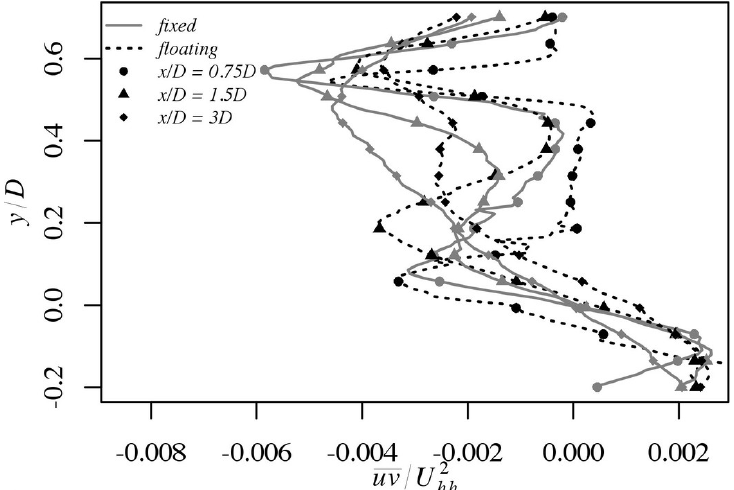
Figure 14. Near wake profiles of uv / U 2 distances 0.75 D , 1.5 D and 3 D .